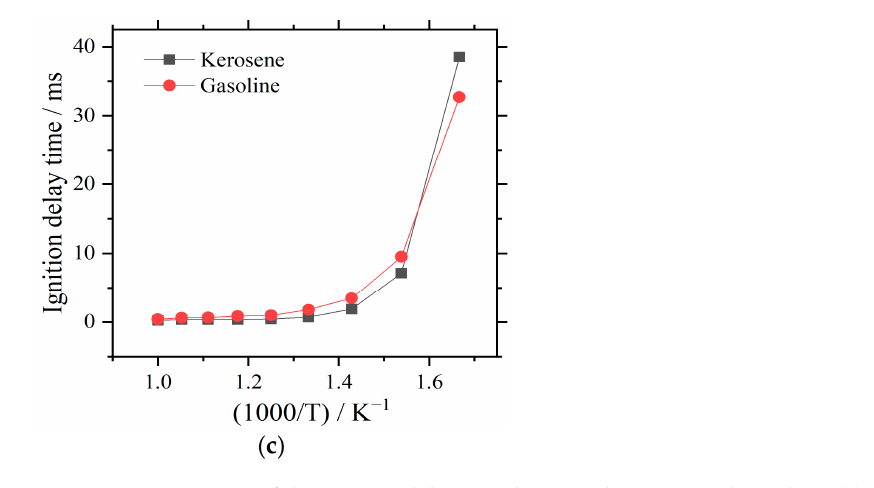
Figure 4. Comparison of the ignition delay time between kerosene and gasoline: ( a ) initial pressure of 15 bar; ( b ) initial pressure of 35 bar; ( c ) initial pressure of 60 bar.